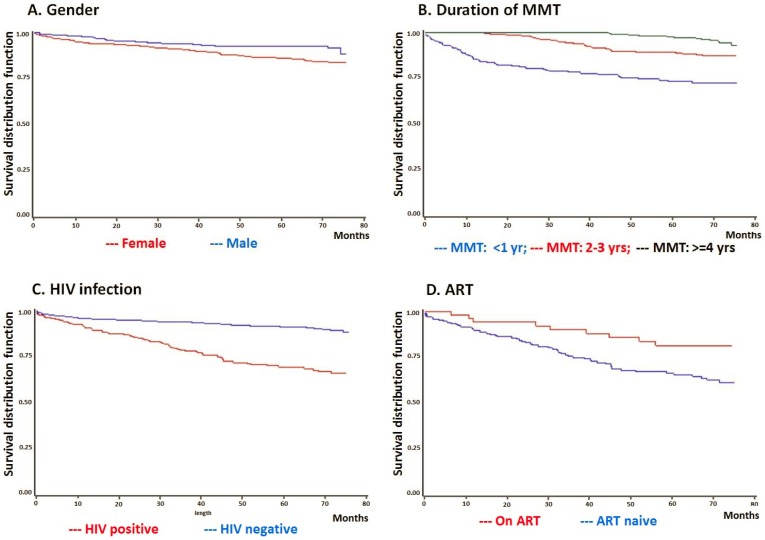
Kaplan-Meier curves by gender, length of MMT, HIV infection and ART.